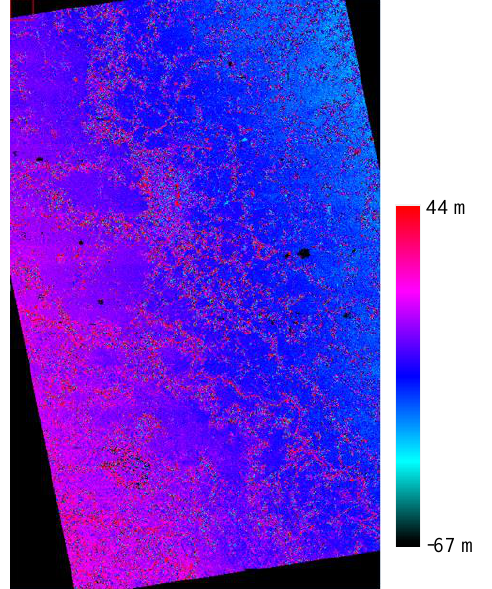
Figure 4. Difference between TanDEM-X DEM and LiDAR DEM shown in colours. Black to cyan to Light blue show negative values and dark blue to red shows positive values.